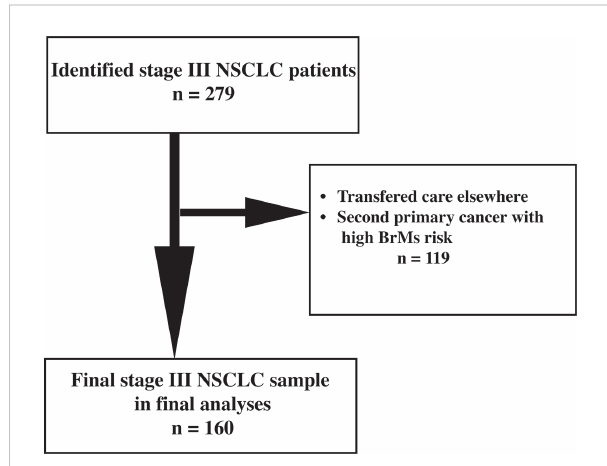
FIGURE 1 Flowchart indicating the selection process of the fi nal study sample of stage III NSCLC. BrMs: brain